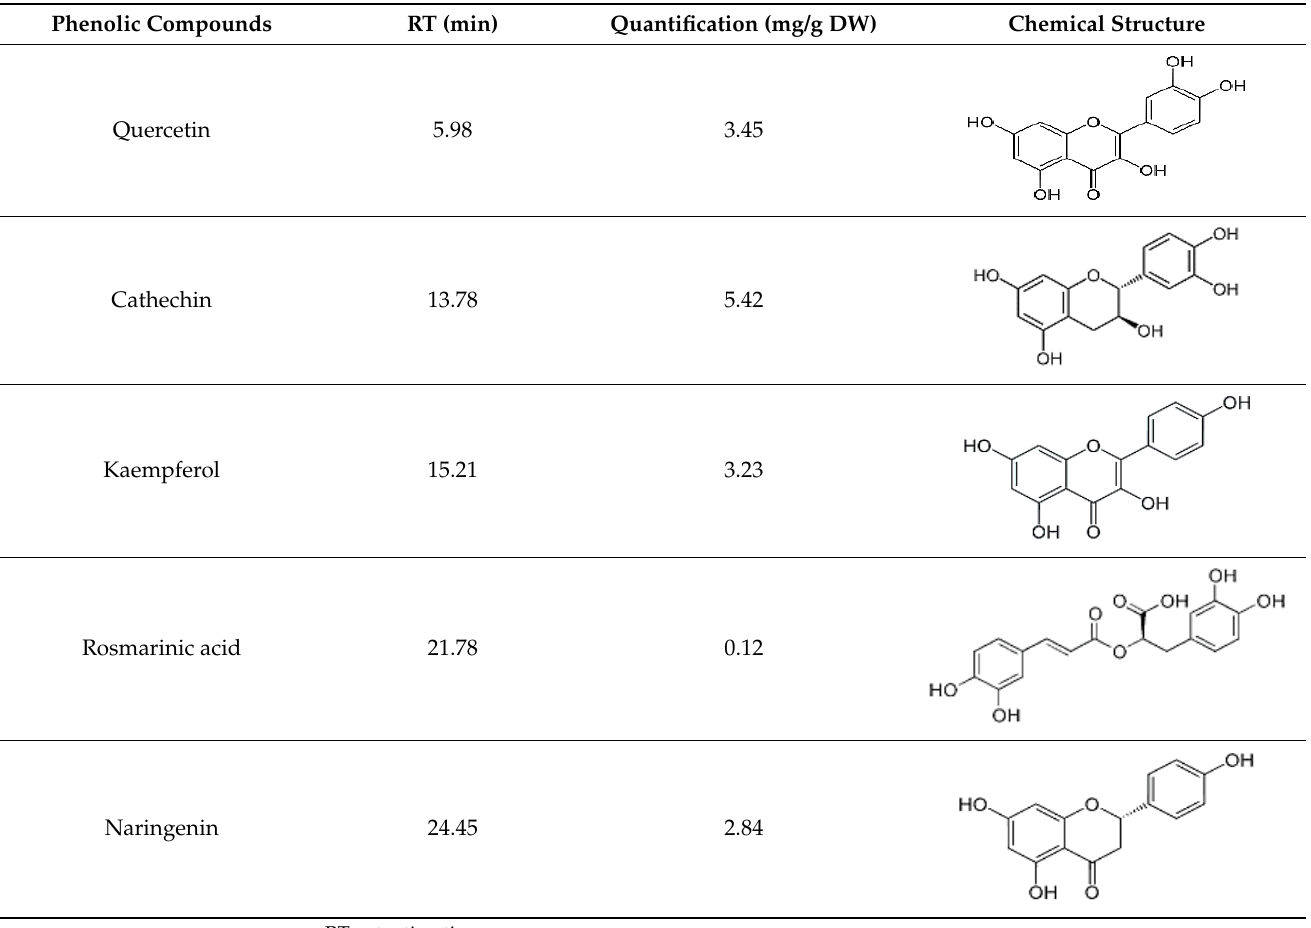
Table 3. The antioxidant activity of Cleome fruits